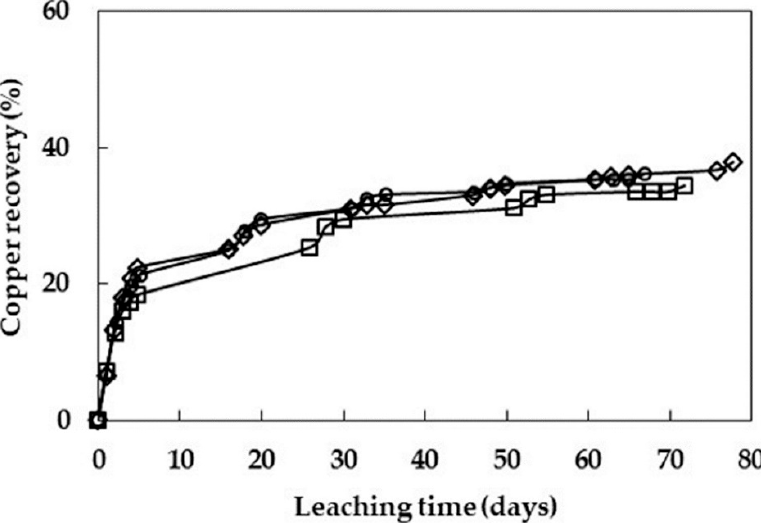
Figure 11. Copper dissolution of chalcopyrite ore with continuous irrigation in 12 g/L of acid, 0.5 g/L copper (II), 1.0 g/L total iron, and 5.0 × 10 7 cells/mL at ambient temperature, with three intermittent irrigation cycles of: 5/10 days; ◇ 5/10 days (duplicate); and □ 5/20 days.